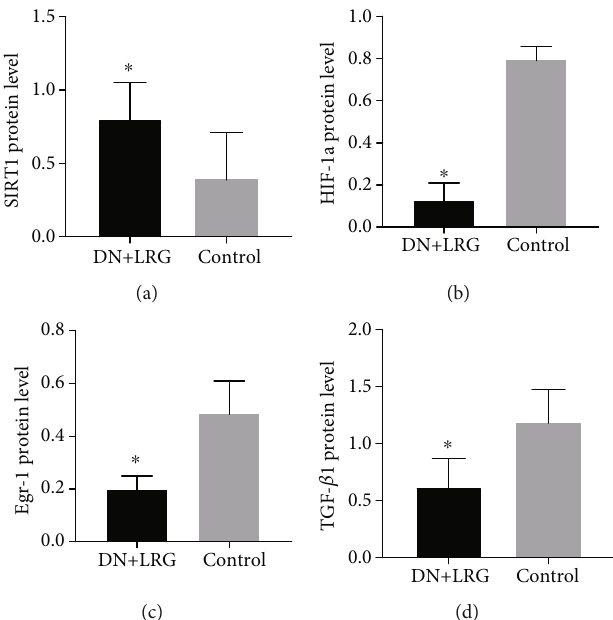
Figure 14: Expression of SIRT1, HIF-1a, Egr-1, and TGF- β 1 proteins in the liver. Control: diabetic nephropathy group; DN+LRG: diabetic nephropathy+liraglutide group; Egr-1: early growth response-1; HIF-1a: hypoxia-inducible factor-1 alpha; TGF- β 1: transforming growth factor- β 1. ∗ P < 0 : 05 vs. the